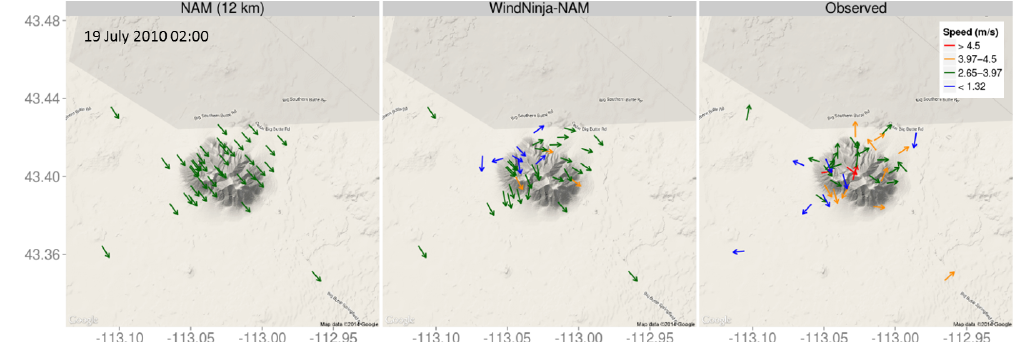
Figure 7. Predicted and observed winds for a downslope flow event at Big Southern Butte.